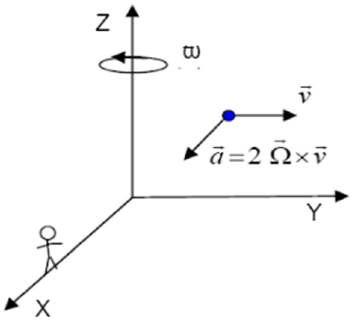
Figure 2. Perception of the Coriolis force.